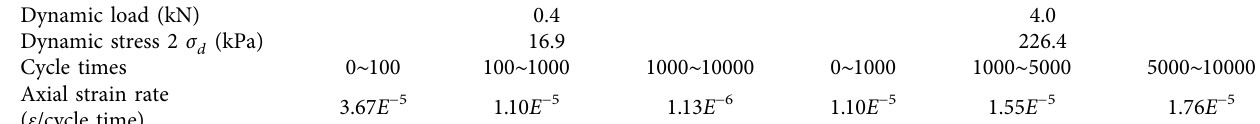
Table 3: Plastic cumulative deformation characteristics of filling under different dynamic loads.